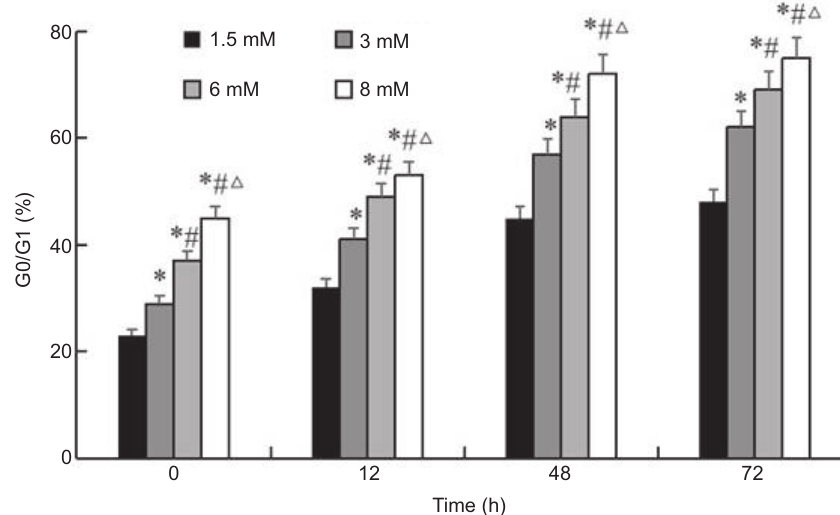
Figure 2: The effects of ligustrazine on cell cycle by flow cytometric analysis. ligustrazine significantly extend the cycle of G0/G1.